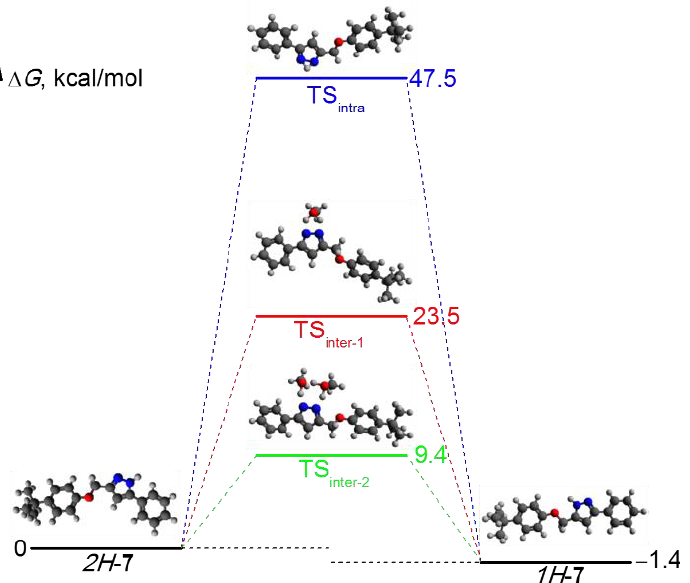
Figure 2. Calculated values of Gibbs free energies of activation (Δ G ≠ ) and reaction (Δ G ) for intramolecular and intermolecular (solvent-assisted) tautomerization of pyrazole 7 . A further evidence of H-bond formation was gained from the refinement of the structure of pyrazole 7 isolated from fraction 7 (cid:48)(cid:48) as needle-like crystals using X-ray diffrac- tometry. This compound crystallized in the triclinic space group P -1, with four independent conformers of compound 7 in the unit cell, which differed by torsion angles N–C–C–O (N13–C18–C62–O111 57.5(2) ◦ , N53–C6–C42–O27 95.8(1) ◦ , N51–C44–C68–O55 8.3(2) ◦ , and N105–C36–C52–O109 90.8(1) ◦ ) (Figure 4a,b). Phenolic fragments and tert -butyl groups